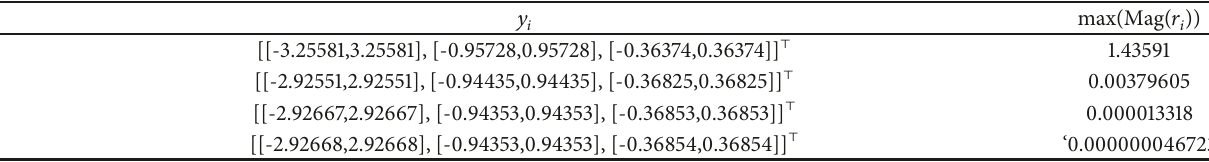
Table 3: Intermediate results of interval steepest descent